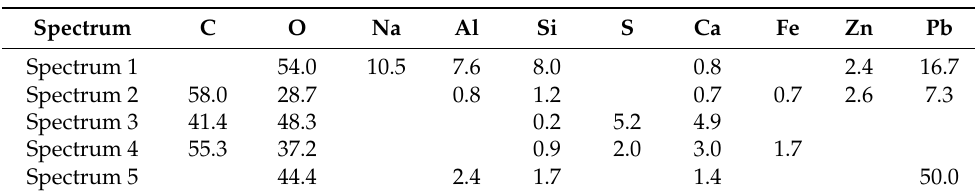
Table 5. Elements detected through EDS analysis of the areas shown in Figure 7a. Results are reported in weight percentage (w%).